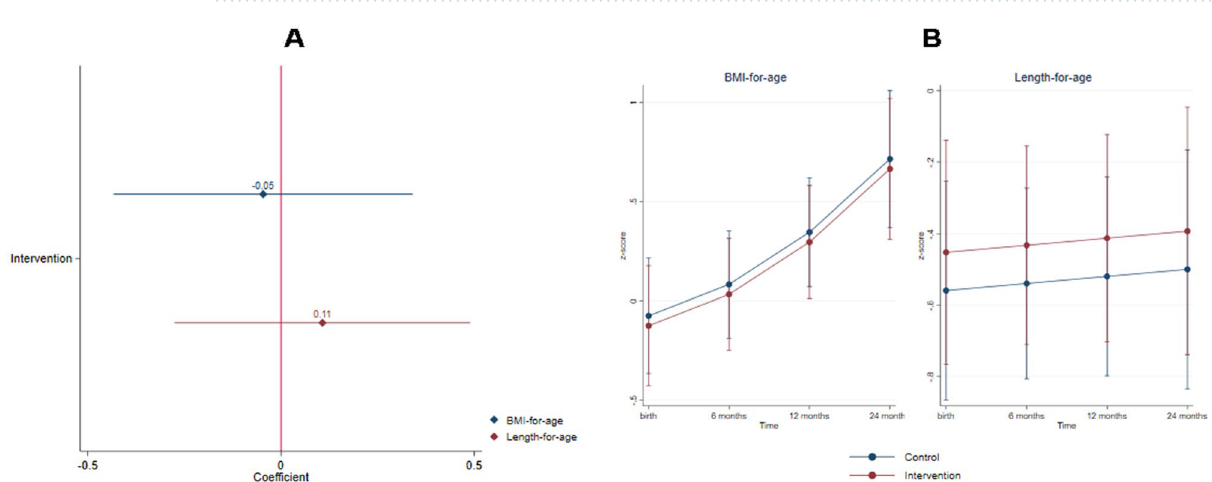
Figure 3. Intervention effects on child development measured by the BSID-III (Intervention 35, control 36). ( A ) Generalized estimating equations models results had the following parameters for each child development domain: cognitive development (coefficient = 0.46, 95% CI [0.85, 1.79], p = 0.488), receptive language development (coefficient = 0.44, 95% CI [− 0.32, 1.19], p = 0.255), expressive language development (coefficient = 0.89, 95% CI [0.18, 1.61], p = 0.014), fine motor development (coefficient = 0.23, 95% CI [− 0.56, 1.04], p = 0.561), gross motor development (coefficient = 1.32, 95% CI [− 0.55, 3.20], p = 0.166). ( B ) Fitted models plots of all child development domains over time by randomization status. Standardized effect sizes (Cohen’s d) were calculated from endpoint marginal means: cognitive development (d = 0.08), receptive language development (d = 0.17), expressive language development (d = 0.37), fine motor development (d = 0.05), gross motor development (d = 0.21).